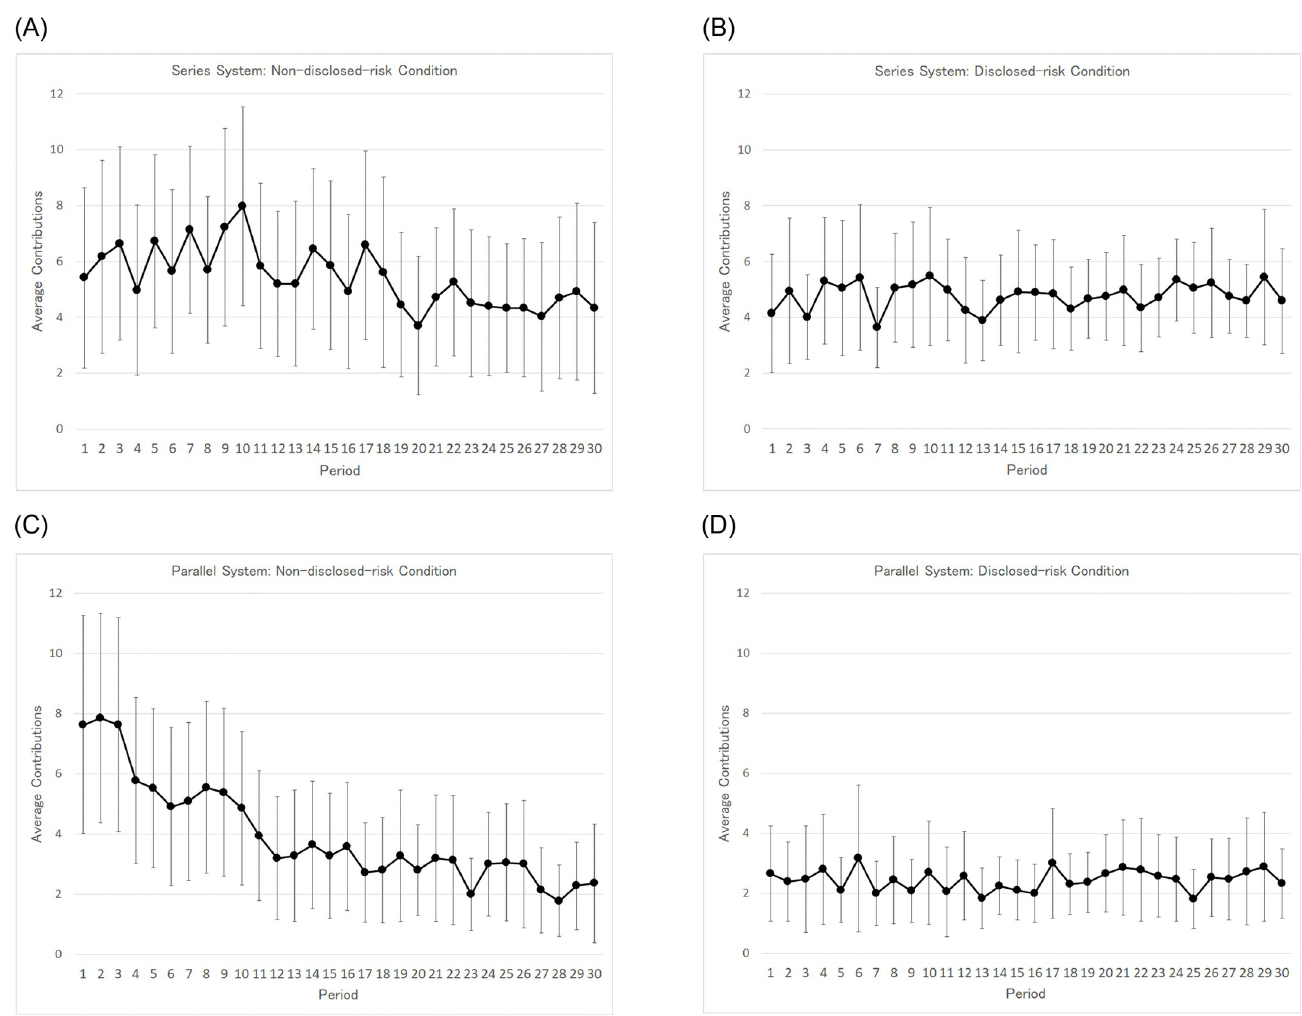
Fig 3. A-D. Average and standard deviation of each period’s